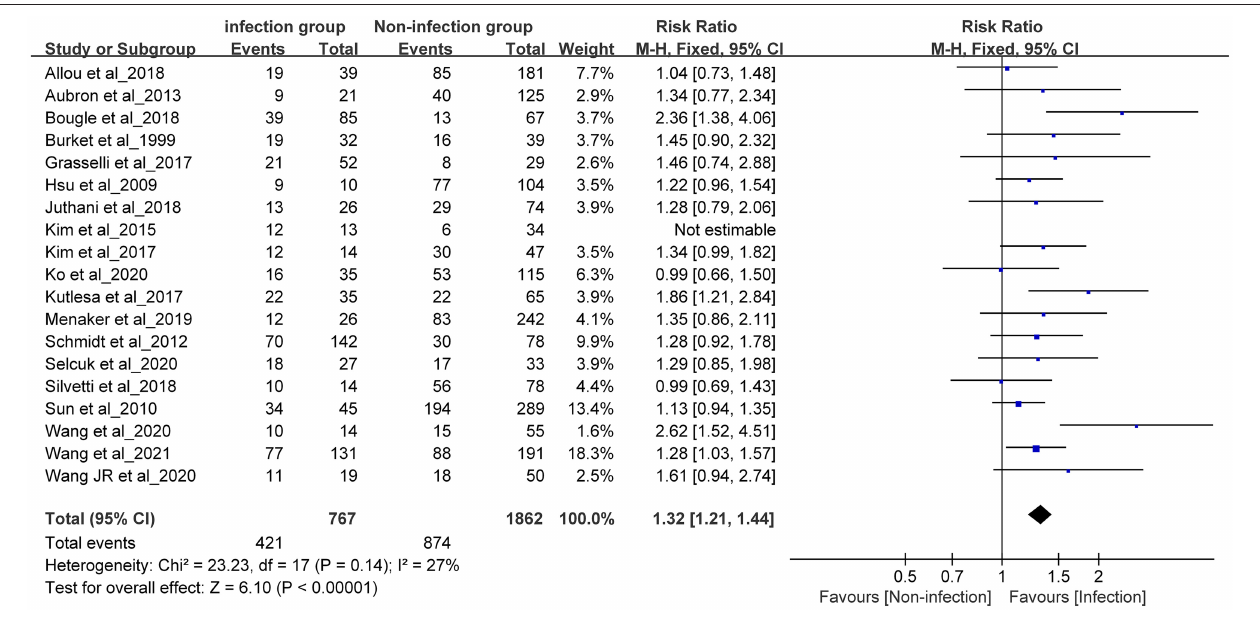
FIGURE 4 | Forest plot was pre-formed with the fixed-effects model after eliminating one study with high